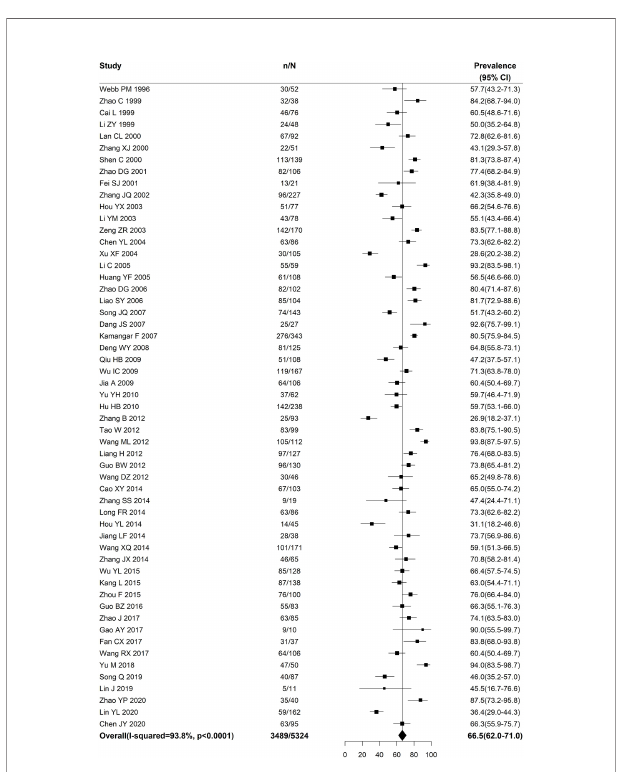
FIGURE 2 | Forest plot for the pooled prevalence of Helicobacter pylori in non-cardia gastric cancer in